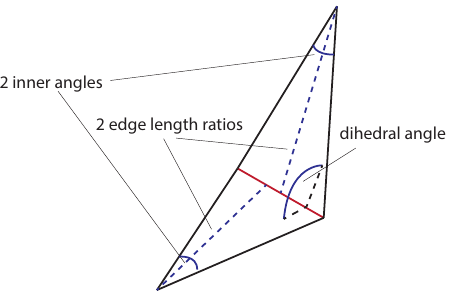
Figure 1. The five geometrical edge features for each face-pair used by MeshCNN (Hanocka et al.,